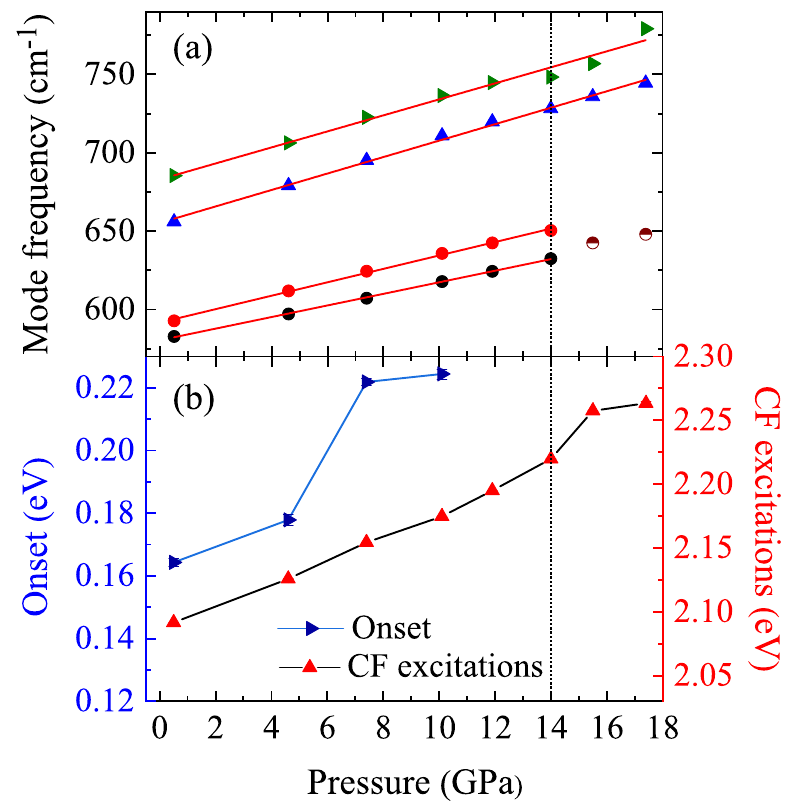
Figure 12. ( a ) Behaviour of infrared-active phonon mode frequencies with pressure. ( b ) Onset of electronic transitions and energy of crystal field (CF) excitation as a function of pressure. The vertical line at ∼ 14 GPa indicates the structural phase